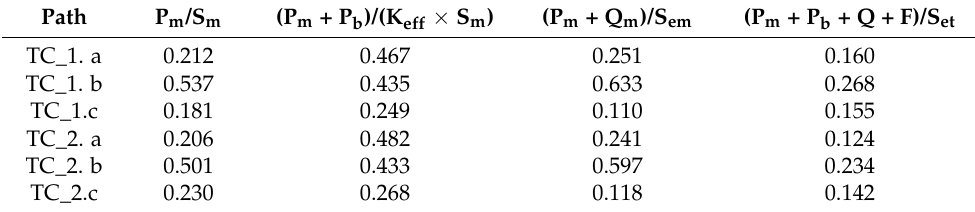
Table 4. RCC-MRx Level D criteria verification within TC domain.